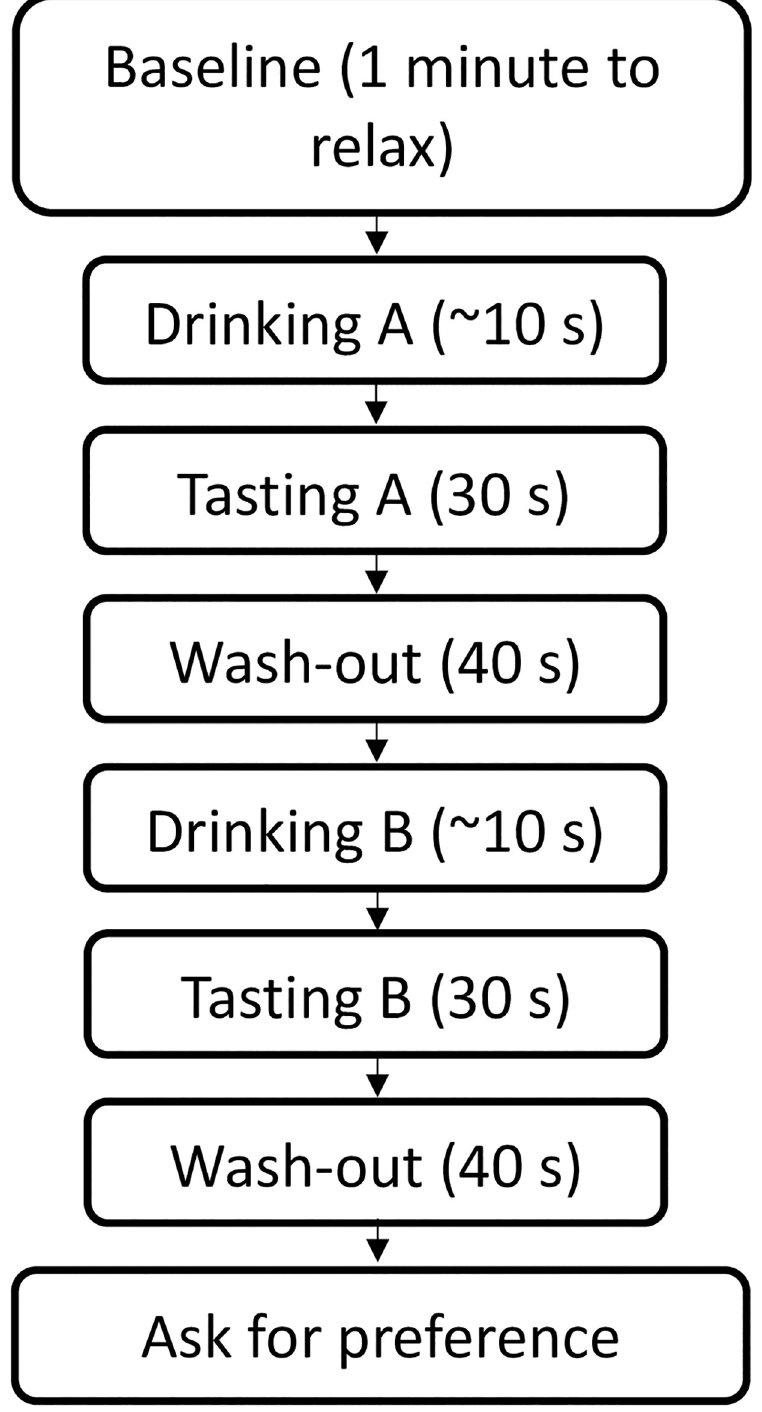
Fig 1. Experimental protocol. Experimental protocol followed in both B and NB condition. After a baseline period during which the subject relaxes, the subject drinks and, after swallowing, tastes the beverage. Then the second beverage is offered, after a wash-out period performed with water. The order of the beverages is random. At the end, the preference between the two soft drinks is asked.